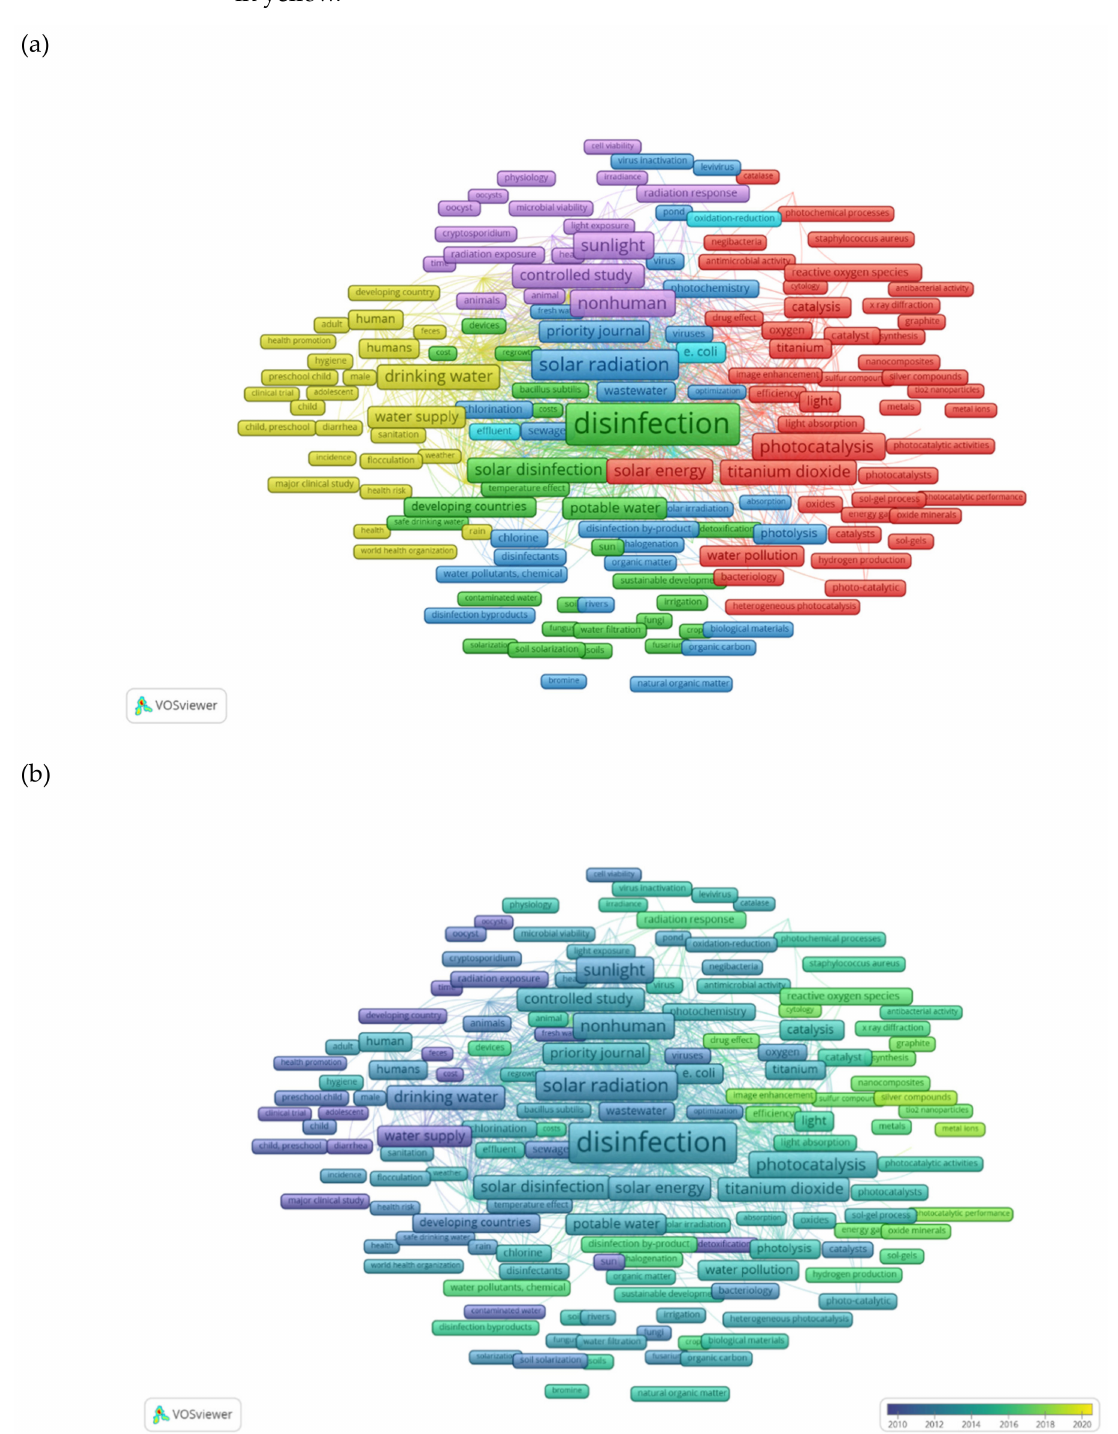
blue (lowest score), intermediate scores are in green, and scores closer to 2020 are mapped in yellow.